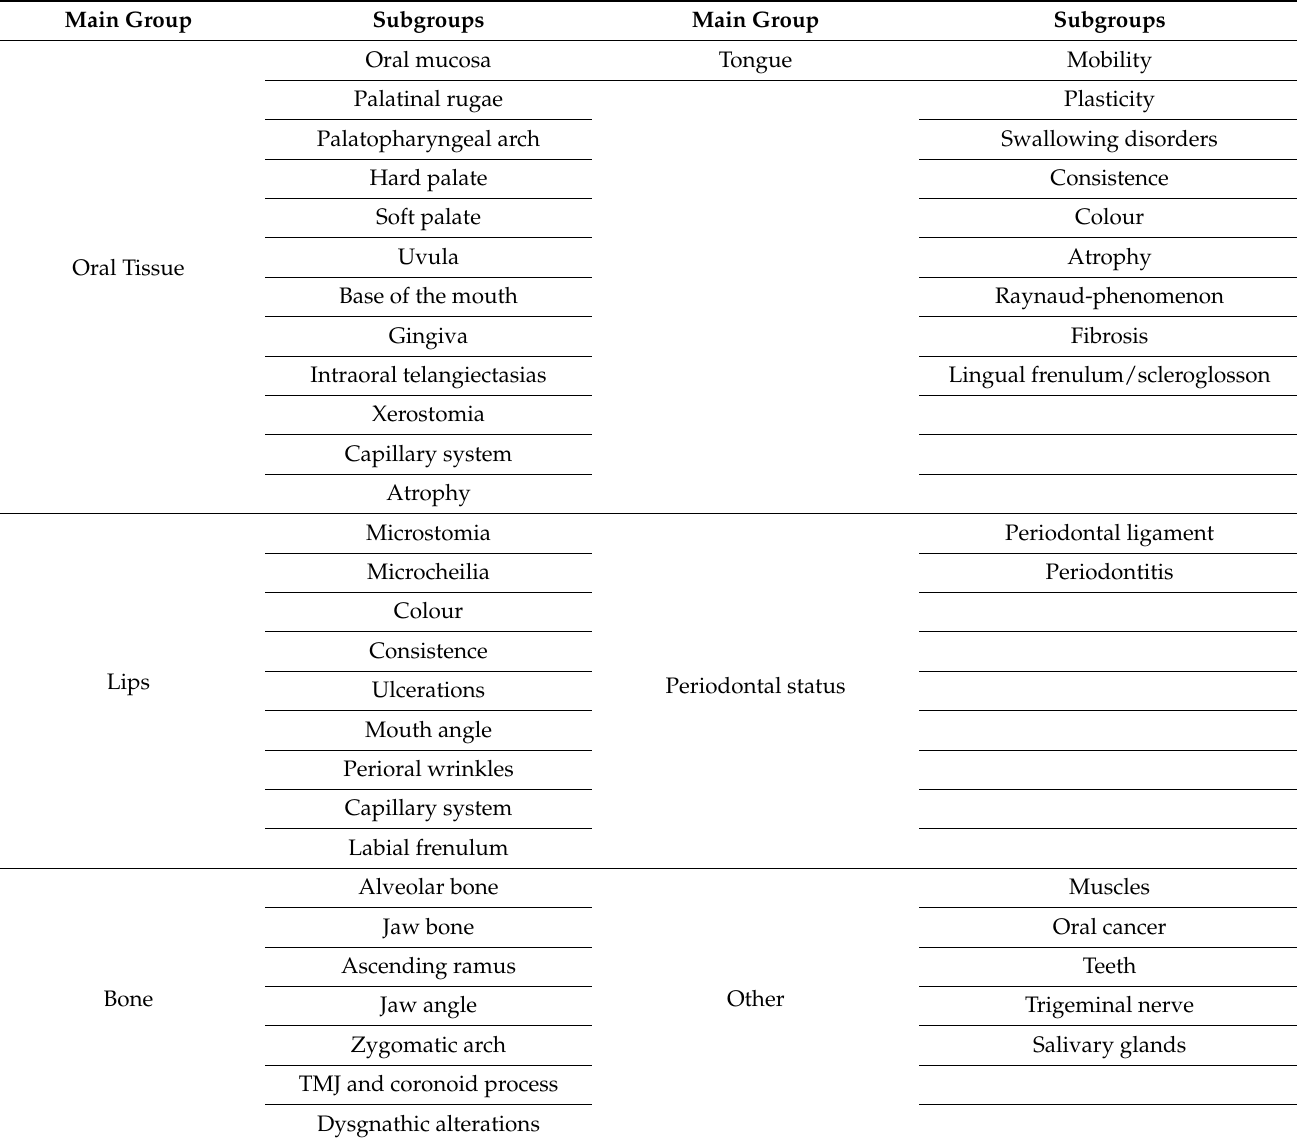
Table 3. Search terms divided in main groups and